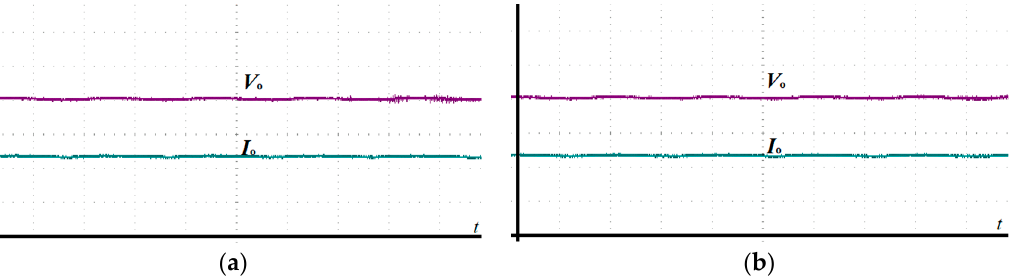
Figure 12. Steady-state response of single-phase H-bridge converter, V o (10 V/div), I o (1 A/div). ( a ) traditional PCC; ( b ) SMPCC.